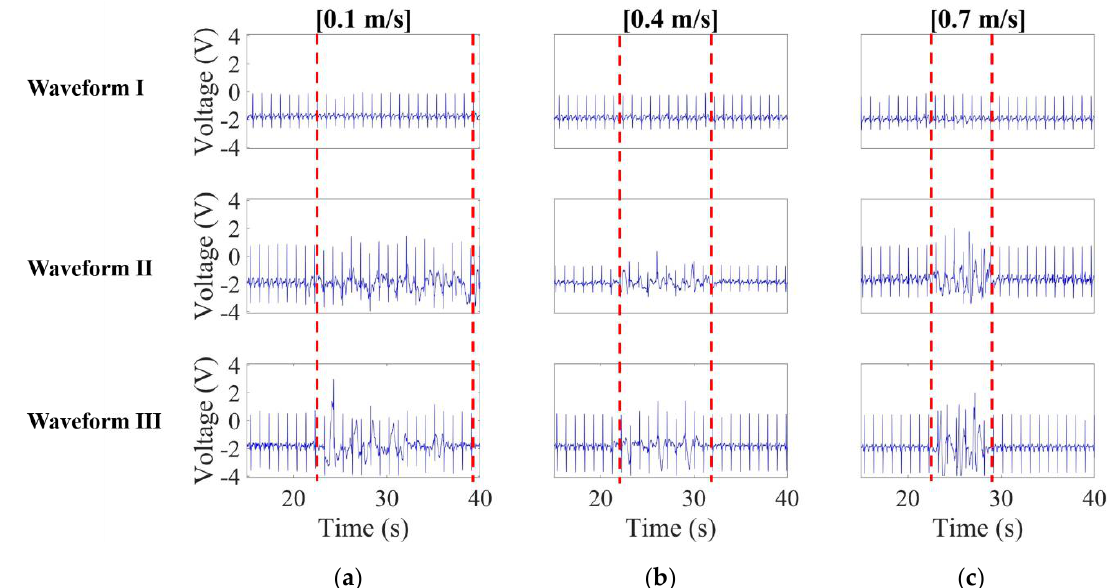
Figure 13. CECG waveform comparison when the simulated noise source approaches the subject at ( a ) 0.1 m/s, ( b ) 0.4 m/s and ( c ) 0.7 m/s.